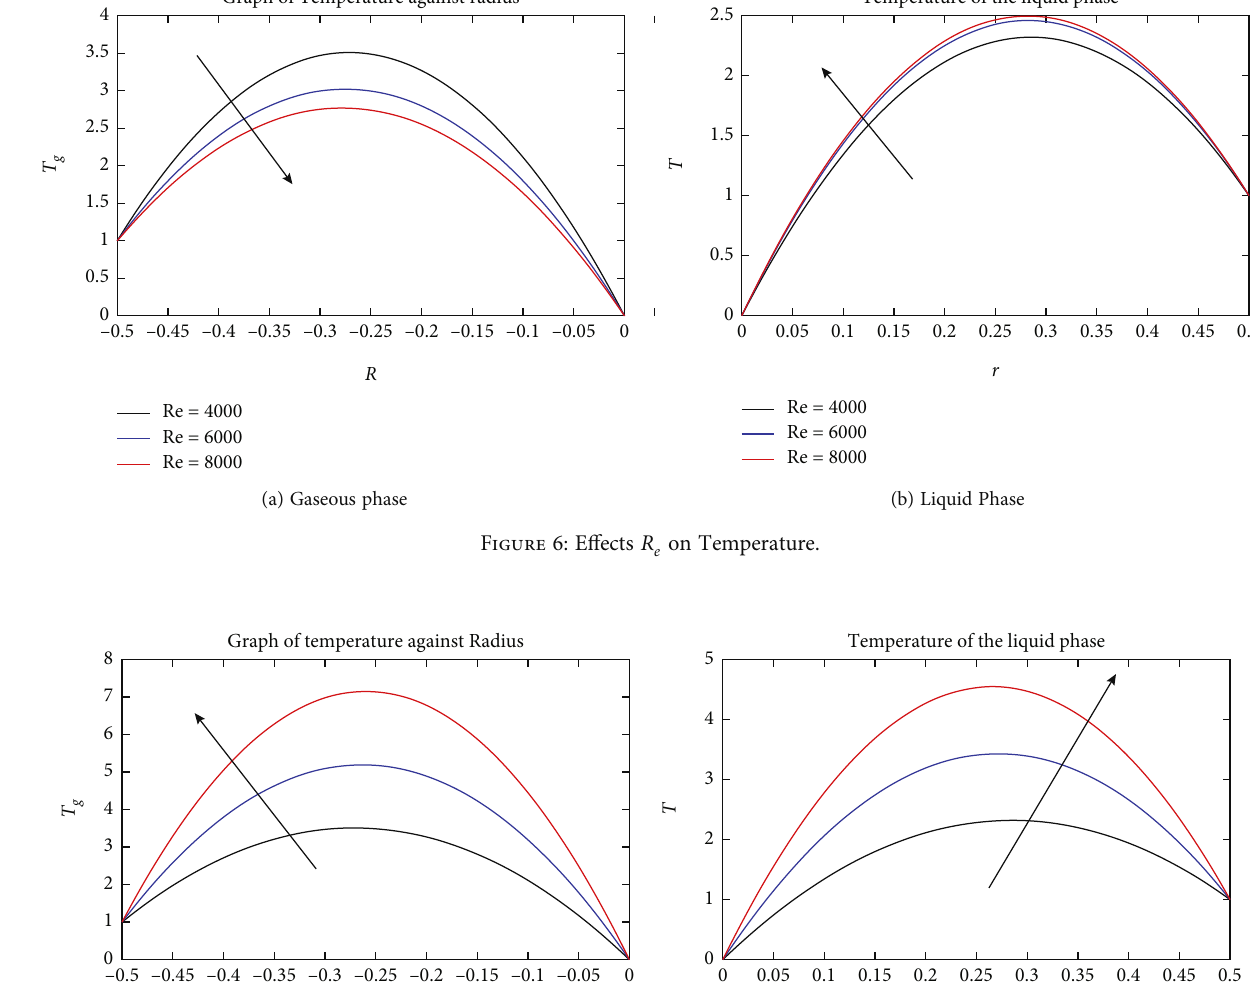
Figure 7: E ff ect Eckert Number on